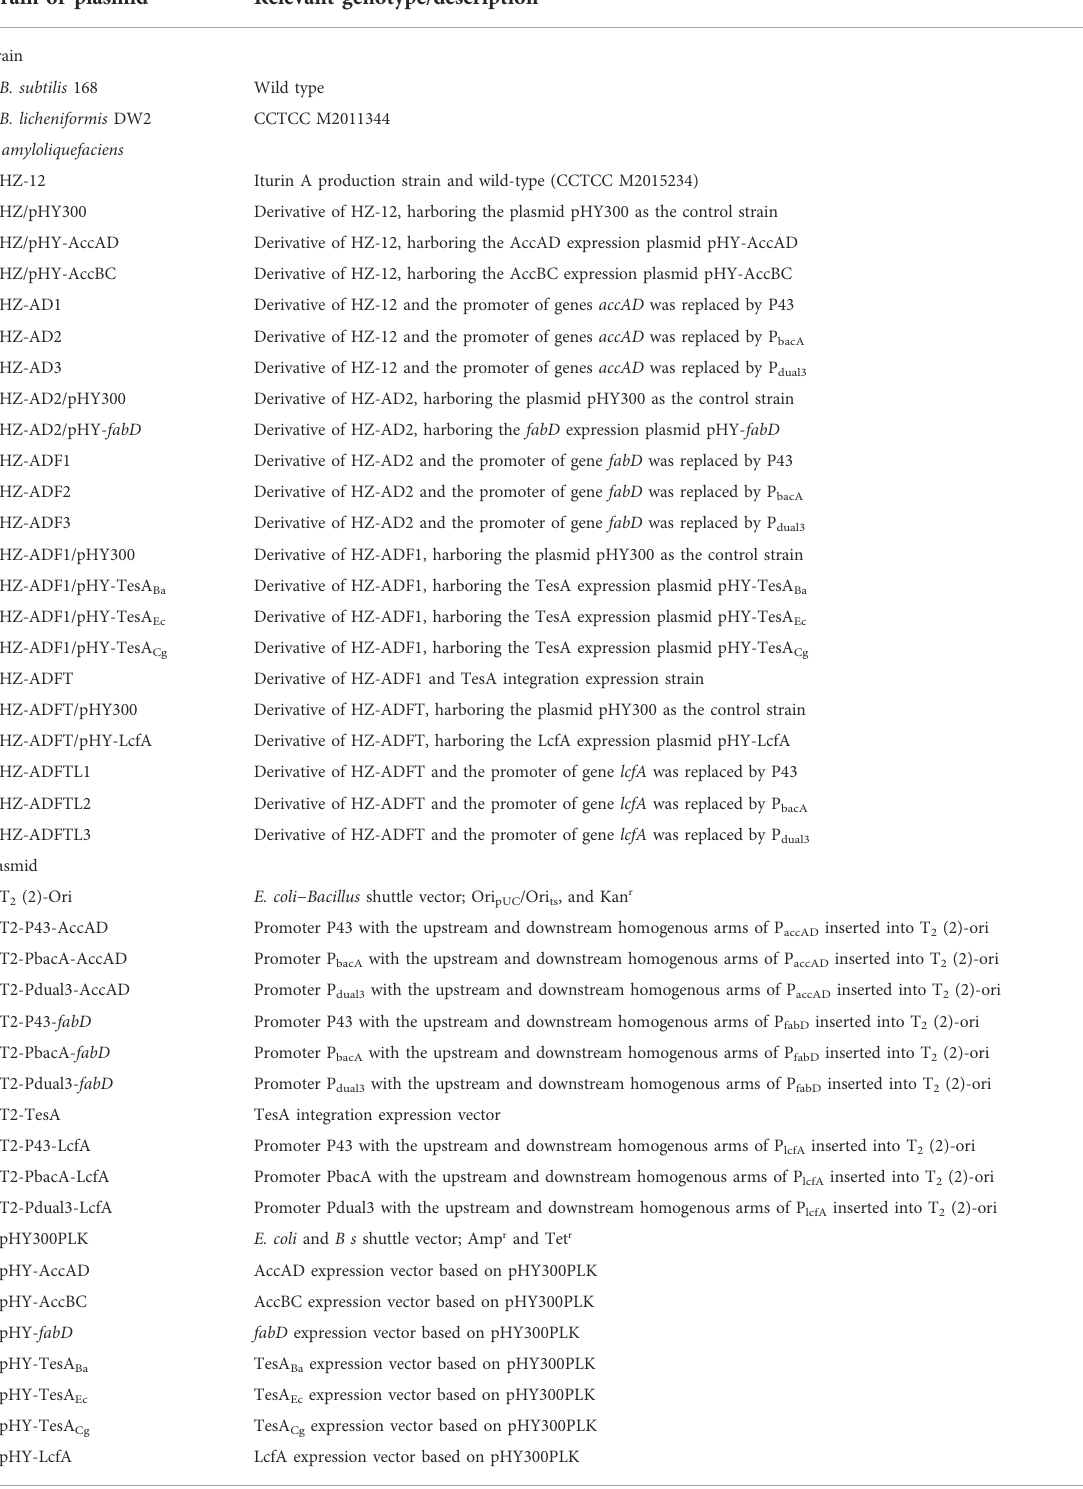
TABLE 1 Strains and plasmids used in this